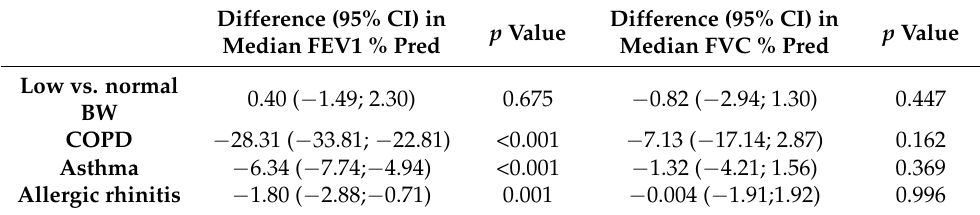
Table 4. Differences (95% CI) in median FEV1 % predicted and FVC % predicted by birthweight, estimated by median regression and adjusting standard errors for intra-centre correlation (n = 2049). Difference (95% CI) in Difference (95% CI) in p Value Median FVC % Pred Median FEV1 % Pred